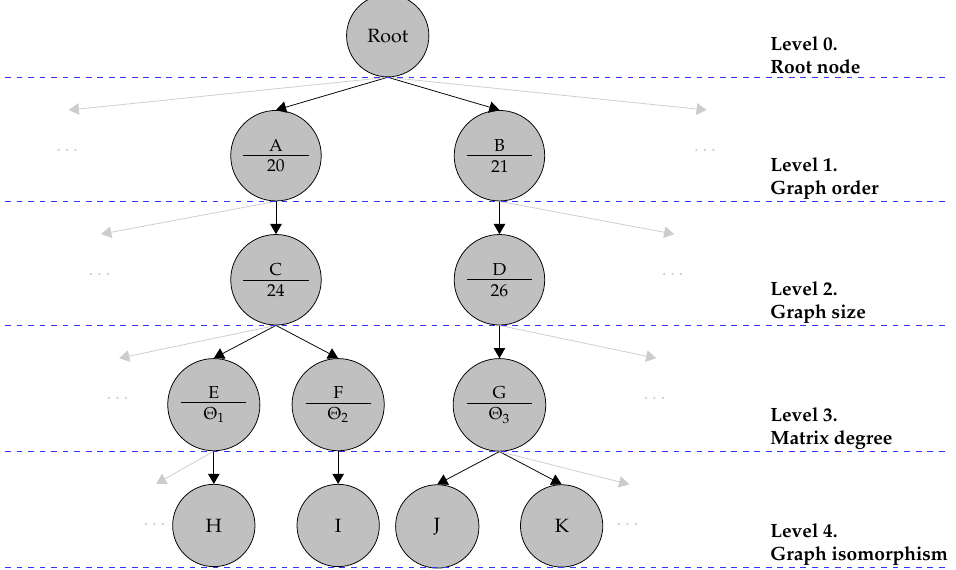
Figure 9. Shown is a slice of a database tree for the clustering of the VID based on isomorphic graphs. Each leaf node at level 4 groups the routes of vehicles crossing intersections whose graphs are isomorphic.